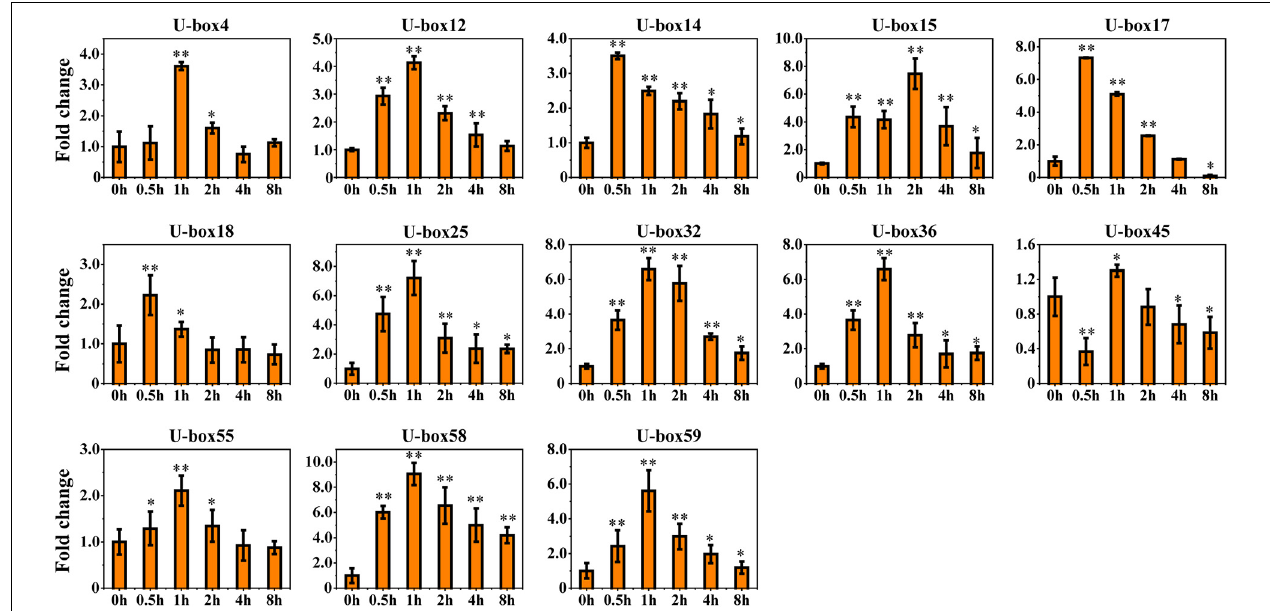
FIGURE 5 | qRT-PCR validation of 13 upregulated genes in response to ABA treatment in RNA-seq dataset. The relative gene expression level changes were normalized to the control without ABA induction at 0 h. Student’s t -test was used with two significance levels ( ∗∗ P < 0.01; ∗ P < 0.05), and the data presented the average of three replicates.